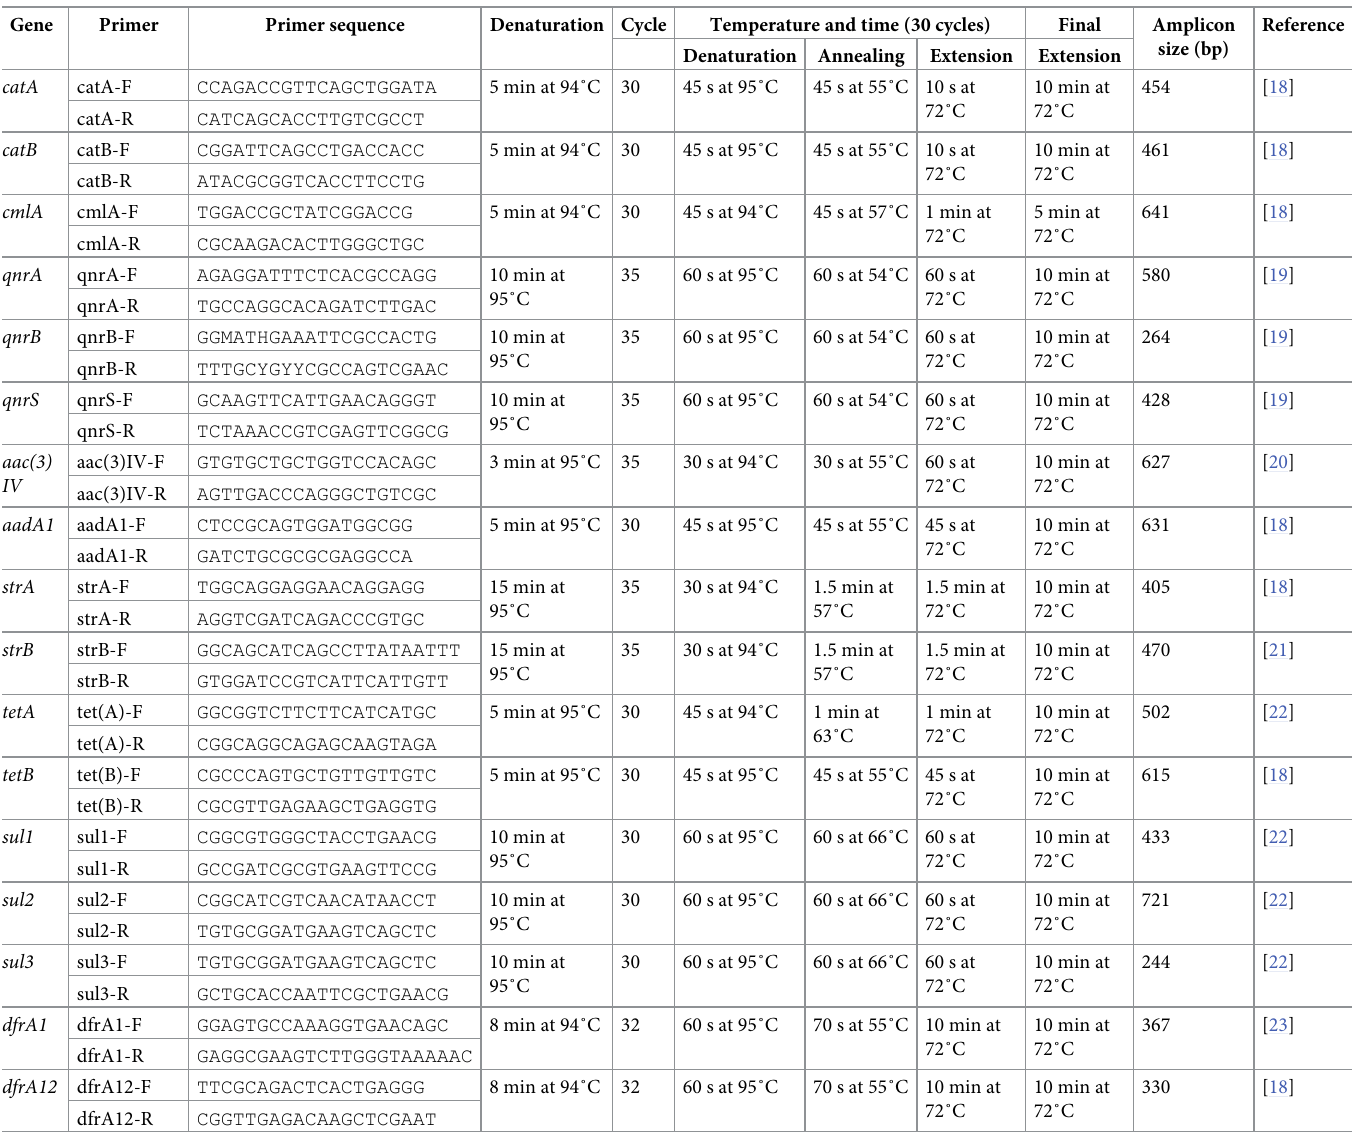
Table 1. Primer used and PCR condition for antimicrobial resistance